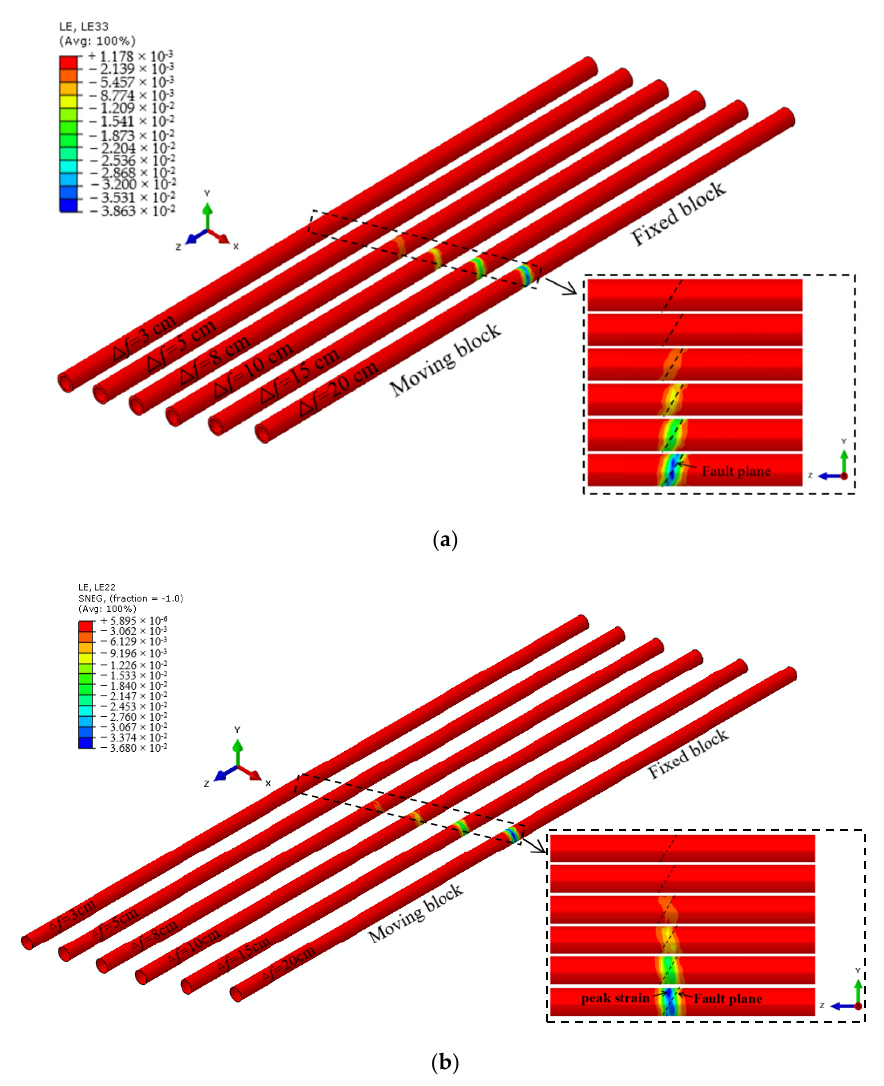
Figure 5. Axial strain nephogram under different fault displacements ( β = 60 ° ; Stiff): ( a ) Concrete lining and ( b ) steel tube lining.